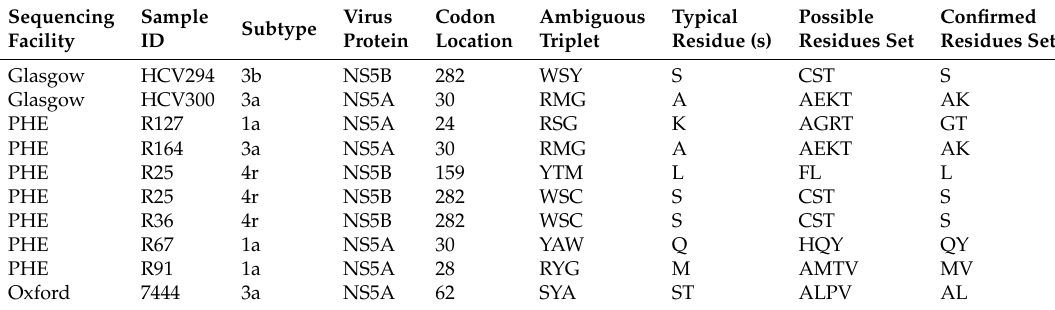
Table 1. Ambiguous resistance-associated locations resolved using GLUE